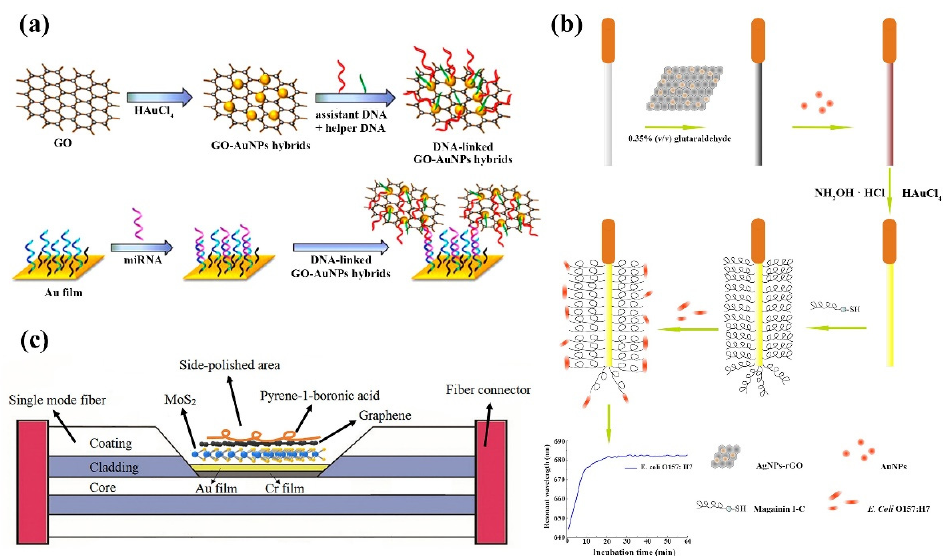
Figure 13. ( a ) Schematic diagram of the GO-Au-SPR biosensor process. Reprinted with permission